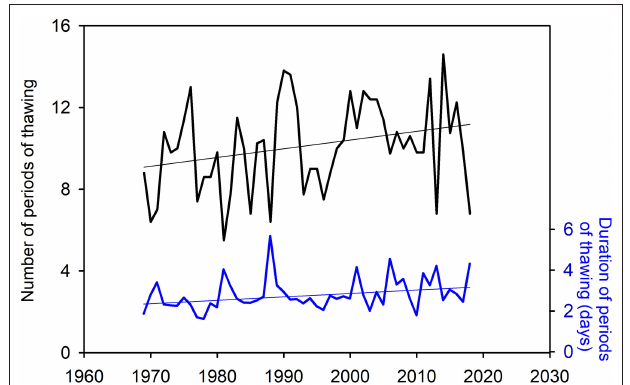
FIGURE 13 | The average number ( n ) and duration (days) of periods of thawing in winter (October to April, O-A) on the reindeer winter pasture area of Finnmarksvidda ( Figure 7 ), 1969–2018. Data combined from five weather stations: Cuovddatmohkki, Karasjok, Kautokeino, Sihccajavri and Suolovuopmi ( Figure 7 ). Trend lines derive from linear regression models: Number of days year = [(0.043 · year) – 74.993], r 2 = 0.08, p = 0.05 and Average duration year = [(0.017 · year) – 30.695], r 2 = 0.095, p <